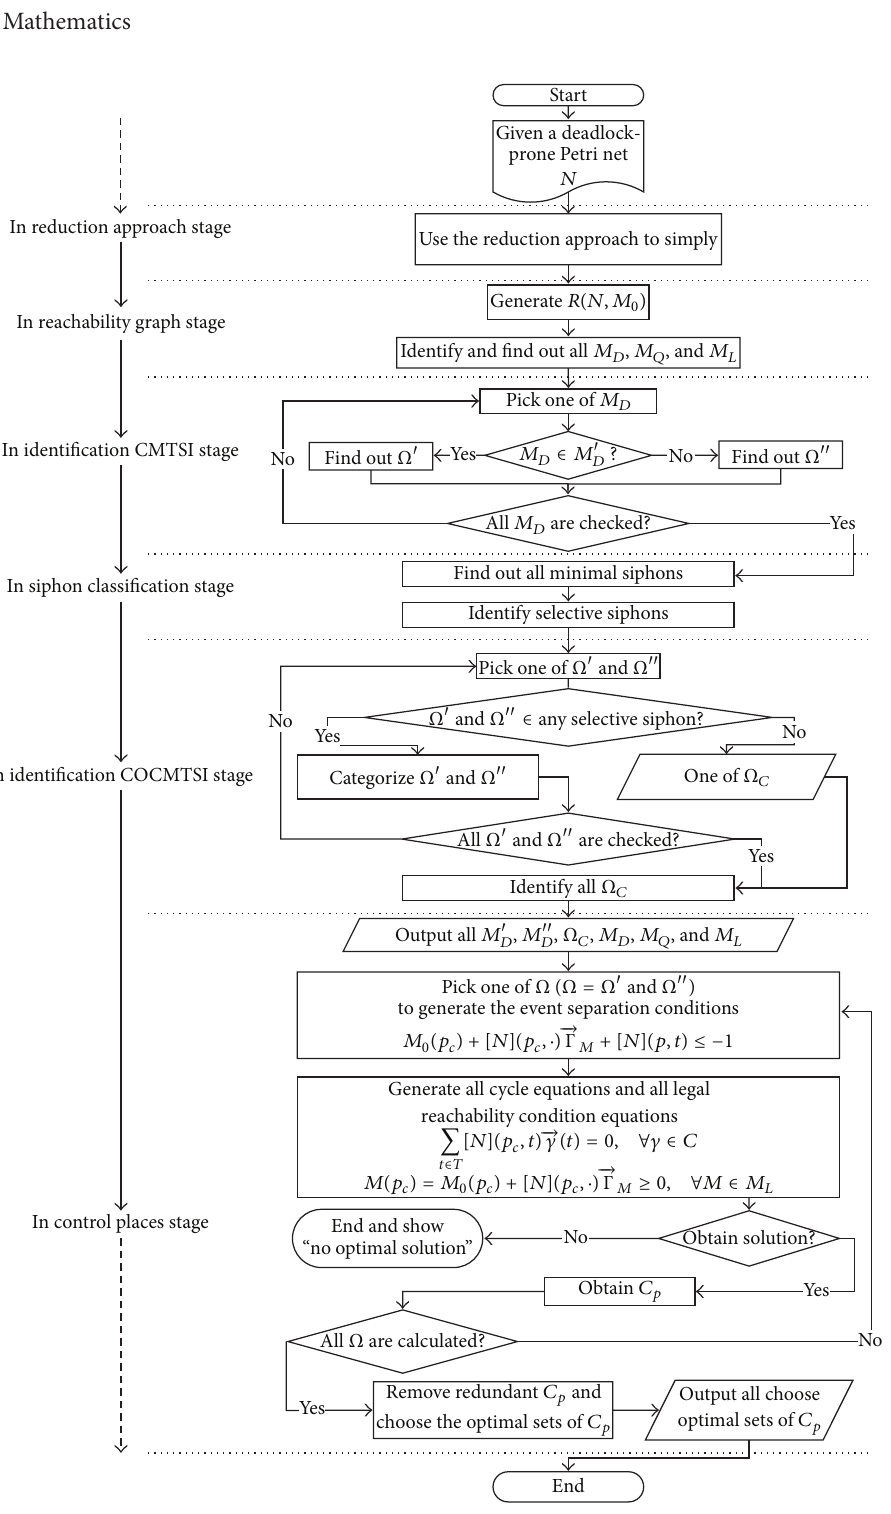
Figure 1: The flowchart of our deadlock prevention